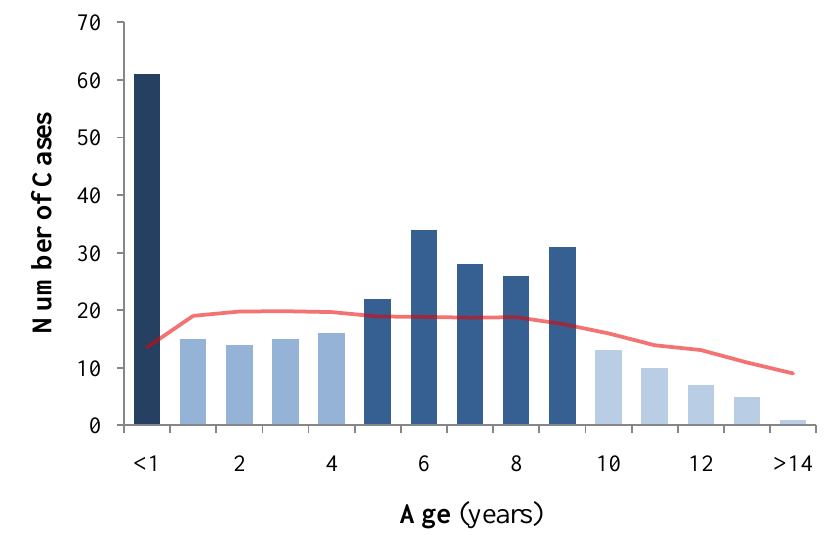
Figure 1. Age distribution of 298 dogs diagnosed with leptospirosis in